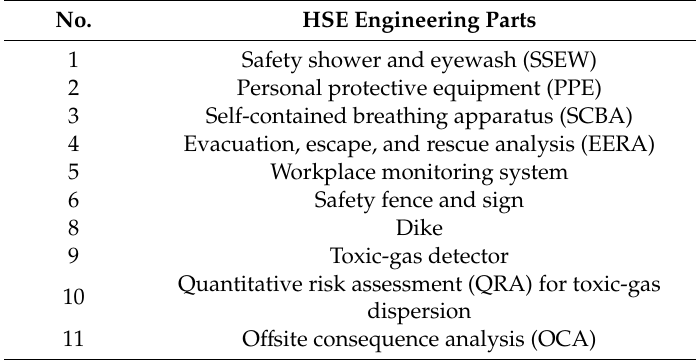
Table 2. HSE engineering